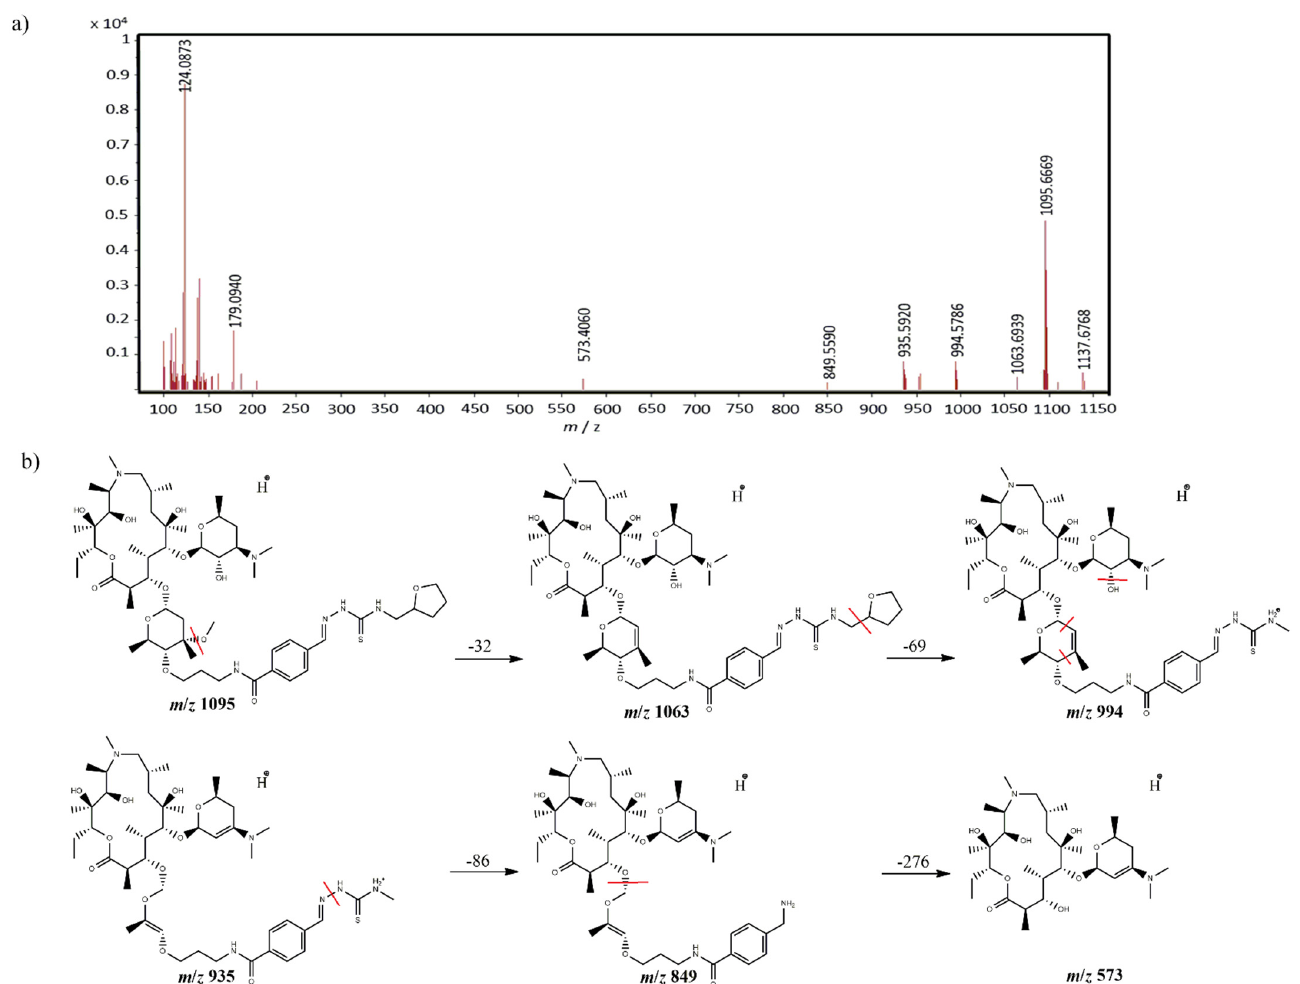
Figure 4. ( a ) MS/MS spectrum and ( b ) fragmentation pattern of 4 ″ -tetrahydrofurfuryl macrozone 3a